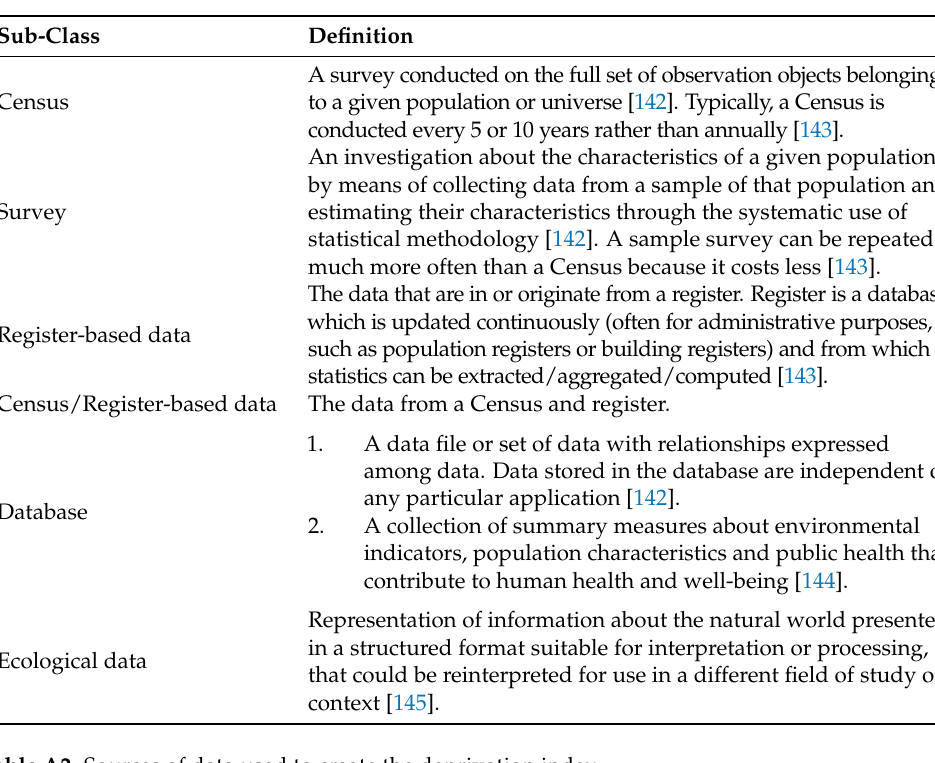
Table A1. Definitions of sub-classes in class “Data source”.